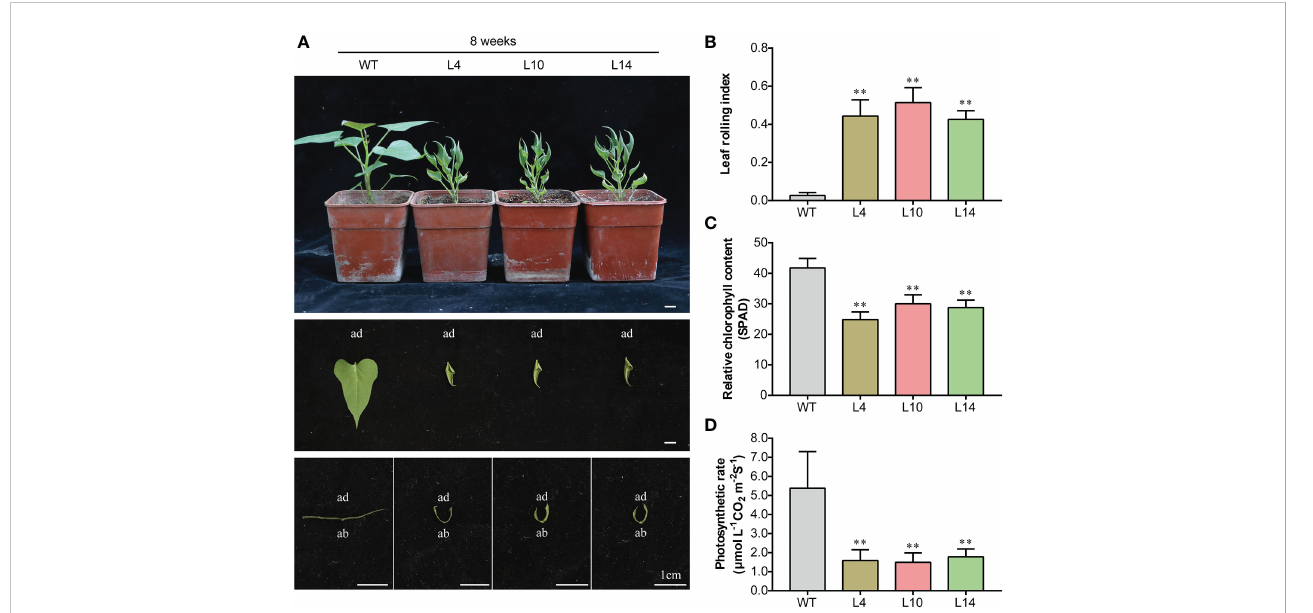
FIGURE 5 Phenotypes of transgenic and wild-type (WT) sweet potato plants in the greenhouse. (A) Plant stature and leaf phenotypes of both WT and transgenic plants. Scale bar , 1 cm. ad , adaxial side; ab , abaxial side. (B) Leaf rolling index (LRI). Data are presented as the mean ± SE ( n = 6). (C) Relative chlorophyll content. (D) Photosynthetic rate. Data are presented as the mean ± SE ( n = 3). Asterisks denote signi fi cant differences based on a Student ’ s t -test. ** p < 0.01.